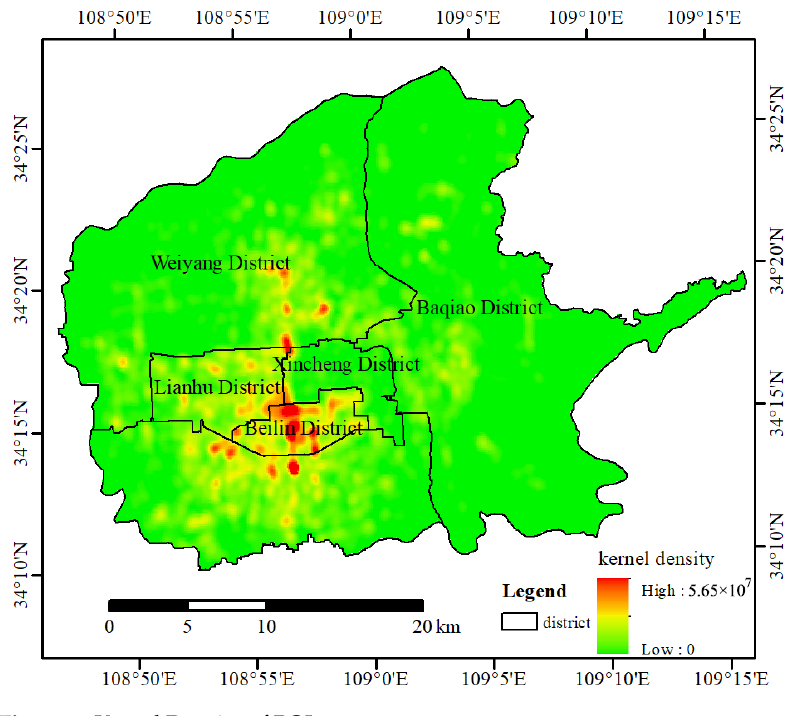
Figure 4. Kernel Density of POI.